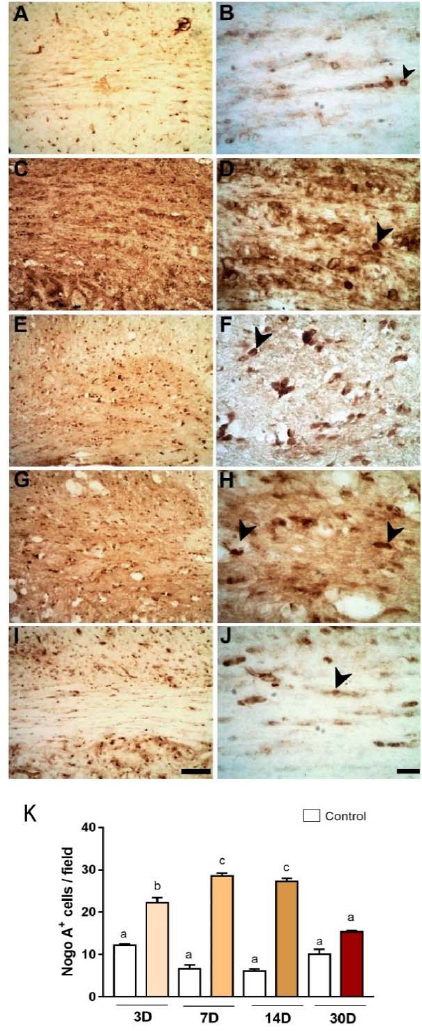
Figure 5. Nogo-A Immunoreactivity in the CC following striatal ischemia. Control animal injected with sterile saline ( A , B ) or ischemic animals injected with ET-1 at 3 ( C , D ); 7 ( E , F ); 14 ( G , H ); and 30 ( I , J ) PLDs. The results of quantitative analysis ( K ) are expressed as mean ± standard error of the mean (SEM). One-way ANOVA with Tukey’s post-hoc test ( p < 0.05). Similar overwritten letters did not show significant statistical differences. Left-sided photomicrographs in lower magnifica- tion with a scale bar of 20 μ m, and right-sided ones, with higher magnification with a scale bar of 100 μ m.